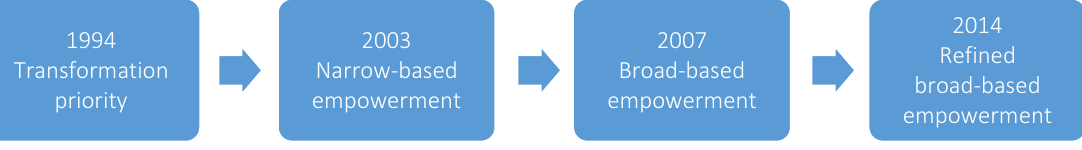
Figure 1. The history of B-BBEE, briefly depicting focal points in